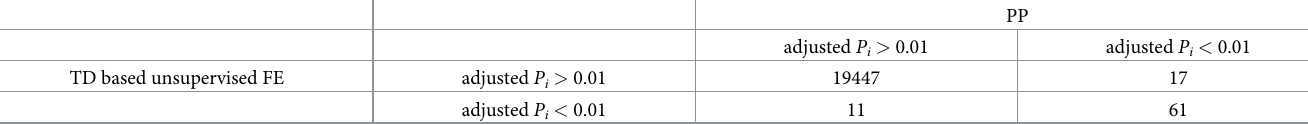
Table 1. Confusion matrix of selected mRNAs between TD-based unsupervised FE and PP in the first data set. P -value computed by Fisher’s exact test is 1.90 × 10 − 149 .